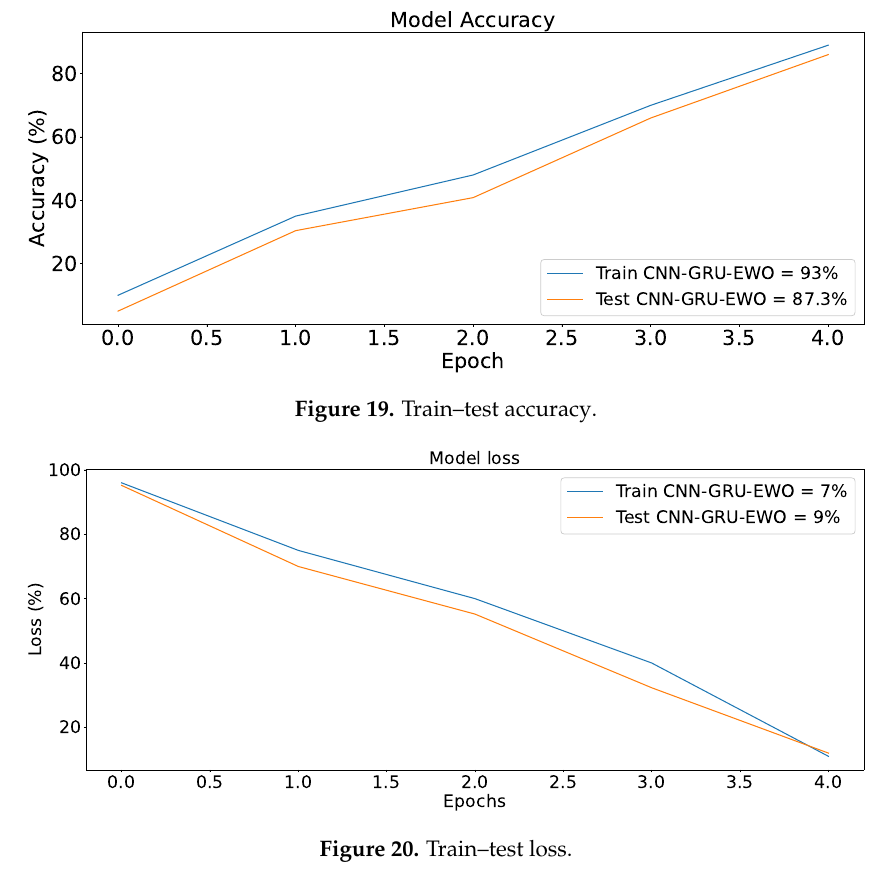
Figure 20. Train–test